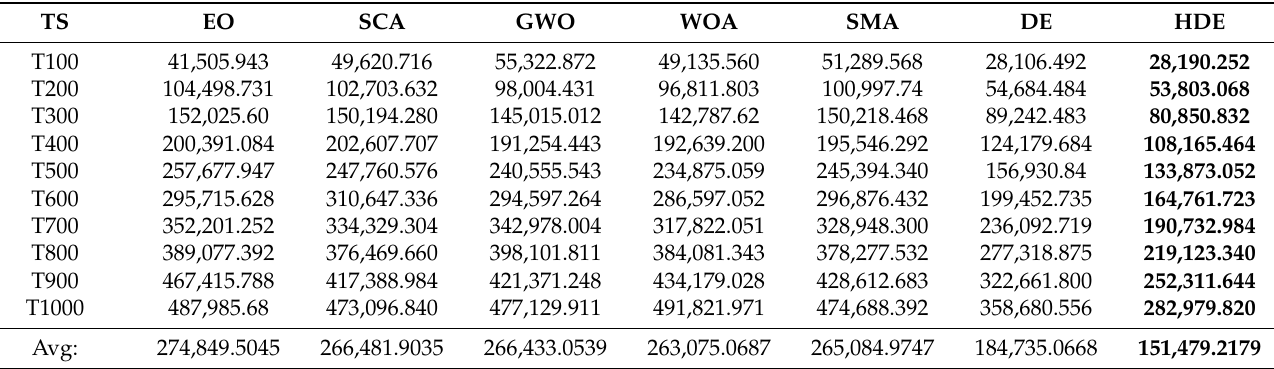
Table 3. Comparison among algorithms in terms of the makespan values for the Cloudsim-based